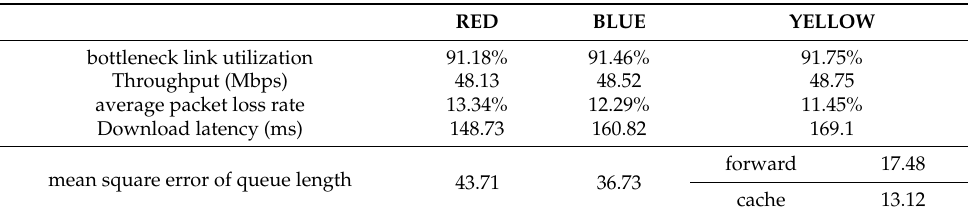
Table 5. Measurement data for light load network in time interval [0,